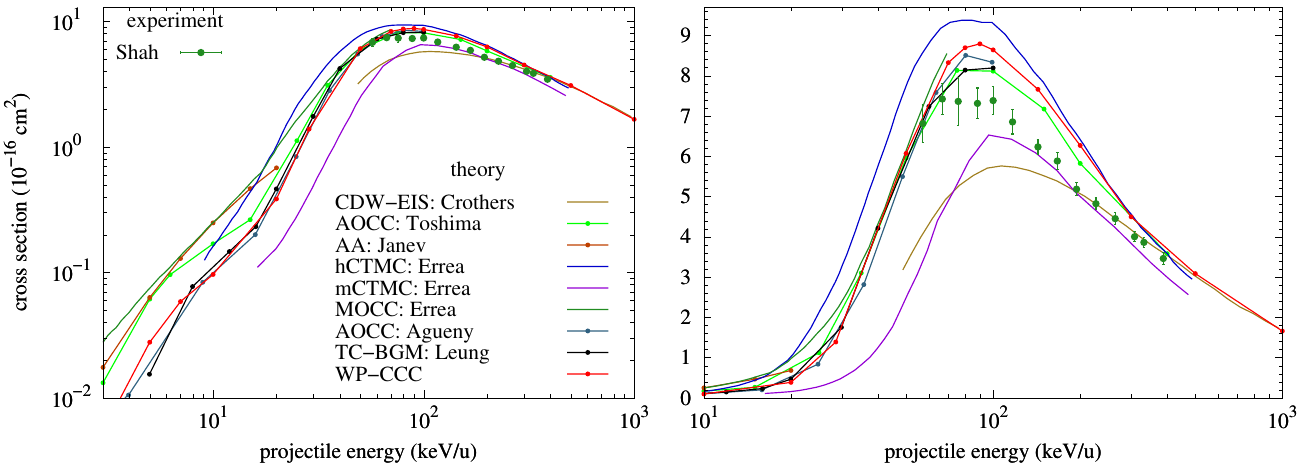
Figure 4. The total cross section for ionisation in Li 3 + − H(1s) collisions as a function of the projectile energy. The present WP-CCC results are compared with the CDW-EIS calculations by Crothers and McCann [18], AOCC calculations by Toshima [37], AA calculations by Janev et al. [20], hCTMC, mCTMC and MOCC calculations by Errea et al. [21], AOCC calculations by Agueny et al. [15] and TC- BGM calculations by Leung and Kirchner [25]. The experimental data are by Shah and Gilbody [10]. The left panel shows a wide energy region using the logarithmic scale. The right panel highlights the low- and intermediate-energy regions using the linear scale. The keys shown in the left panel apply to both